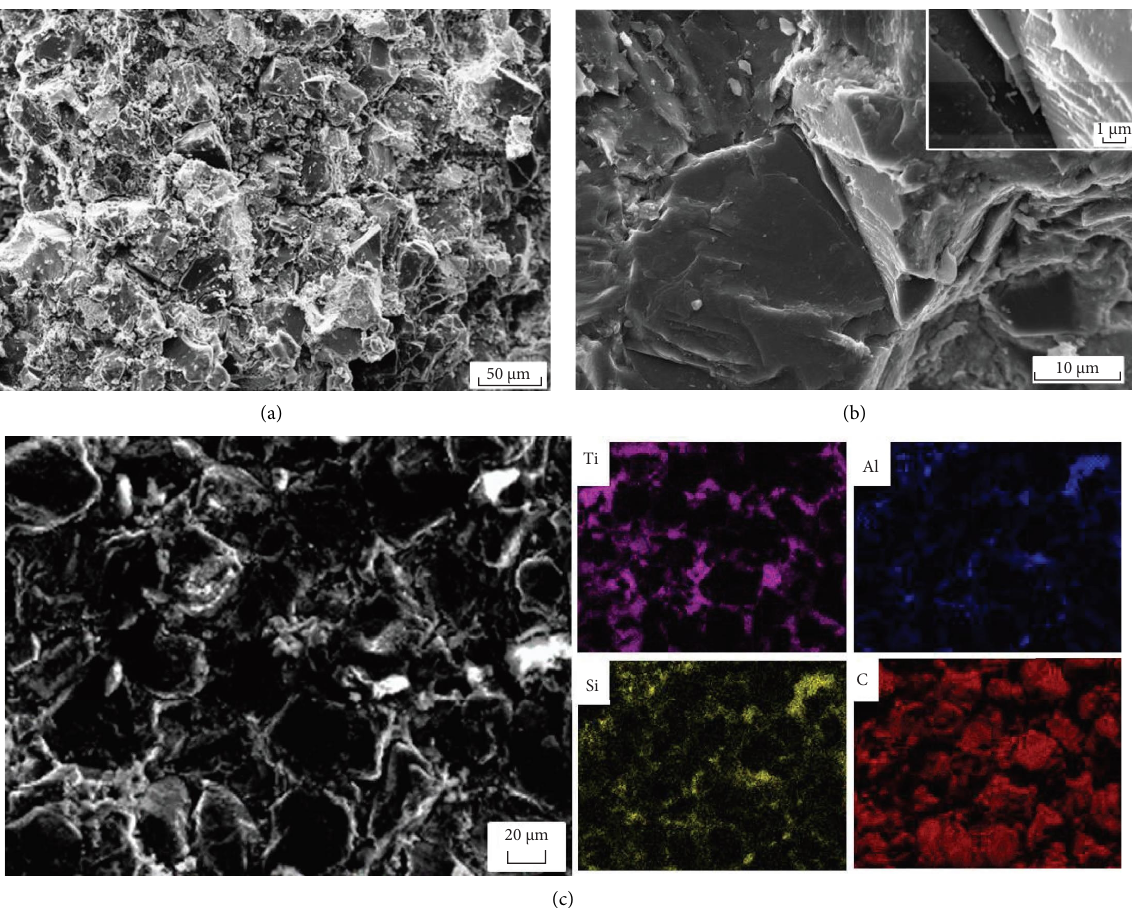
Figure 2: (a) SEM images of the sections of Ti ° C under 5.5GPa; (b) the clear interface 3 Si 0.8 Al 0.2 C 2 –diamond composites sintered at 1050 between diamond and Ti 3 Si 0.8 Al 0.2 C 2 binder; (c) EDS analysis of Ti 3 Si 0.8 Al 0.2 C 2 –diamond